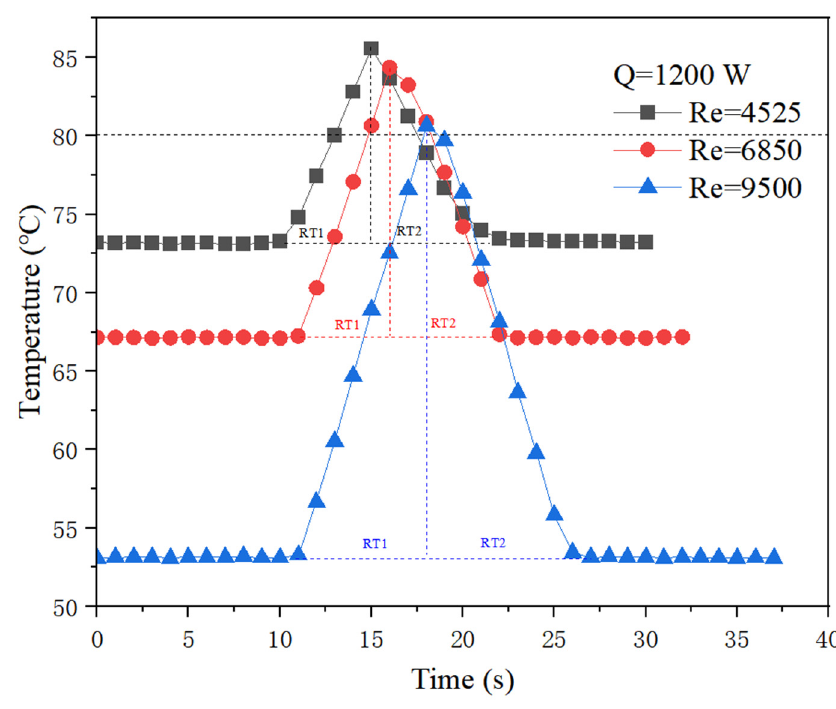
Figure 9. Temperature response characteristics to instantaneous start-stop conditions.